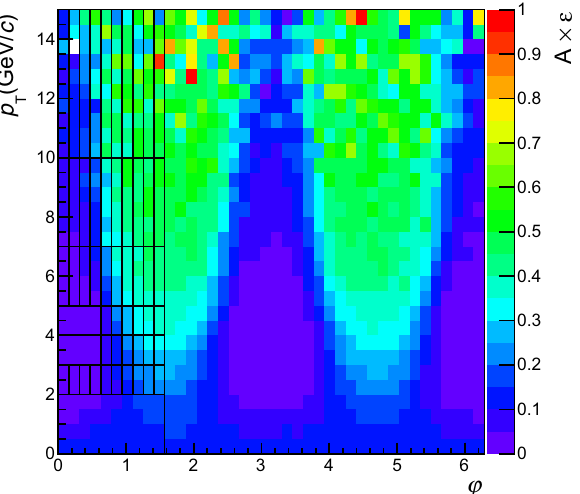
Fig. 1 ( A × (cid:10) ) 2-D maps in the planes (cos θ , p T ) (left) and ( ϕ , p T ) (right) in the Collins-Soper frame. The plots illustrate the symmetry with respect to cos θ = 0 (left) and with respect to ϕ = π and π/ 2